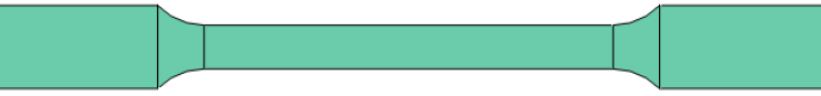
Figure 10. Model of sample created in Abaqus CAE.